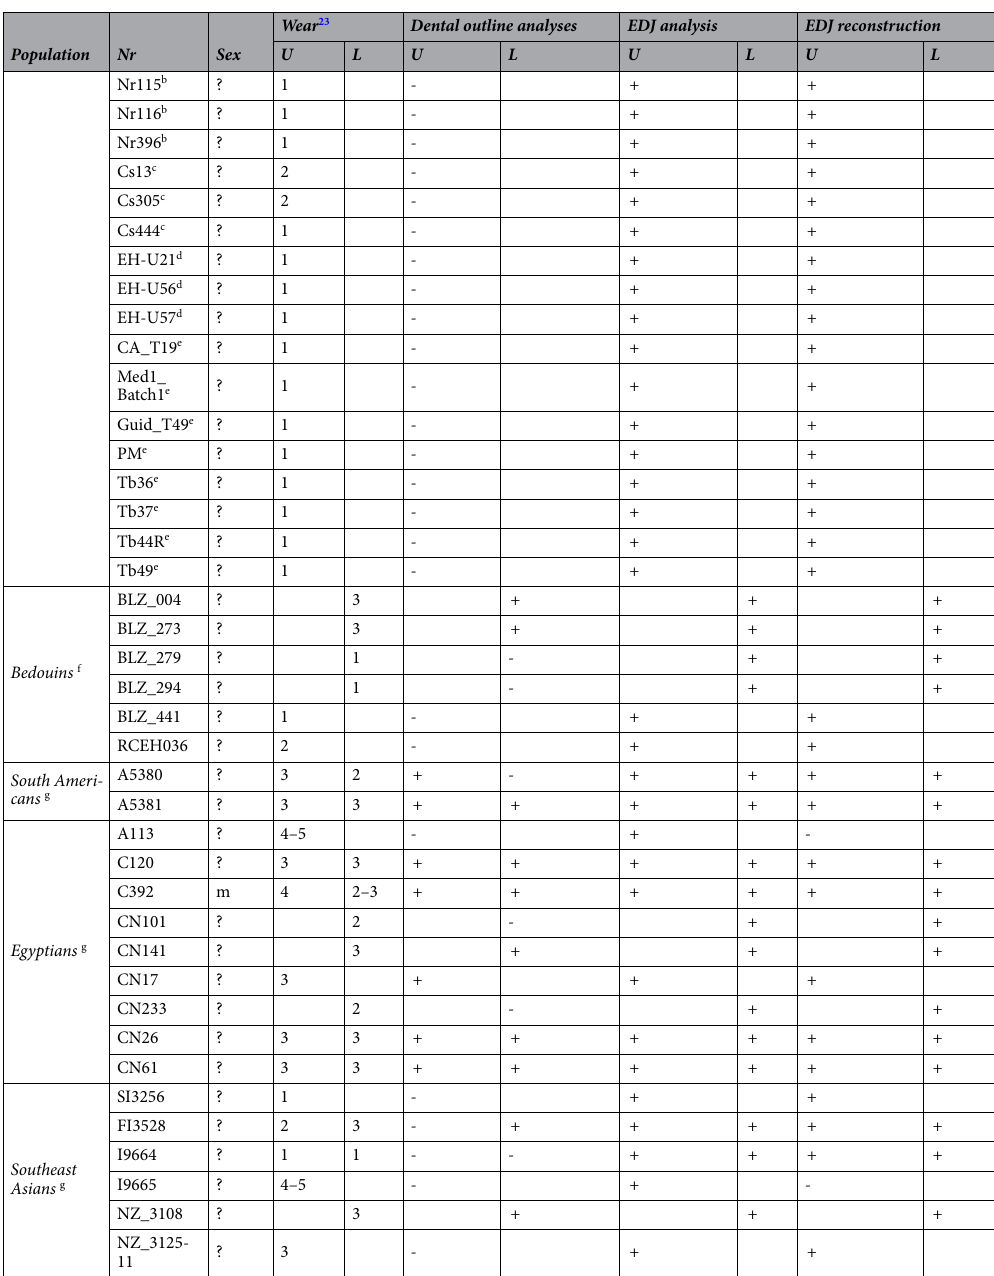
Table 1. List of deciduous second molars used in this study, with associated information such as repository, sex, degree of wear, and analyses performed. It is also reported whether the dentine horns were virtually reconstructed. U = upper; L = lower; f = female; m = male; + = yes; − = no; ? = unknown; EDJ = enamel-dentine junction. a Université de Paris, Plateforme Imageries du Vivant. b Anatomy Collection of the Medical